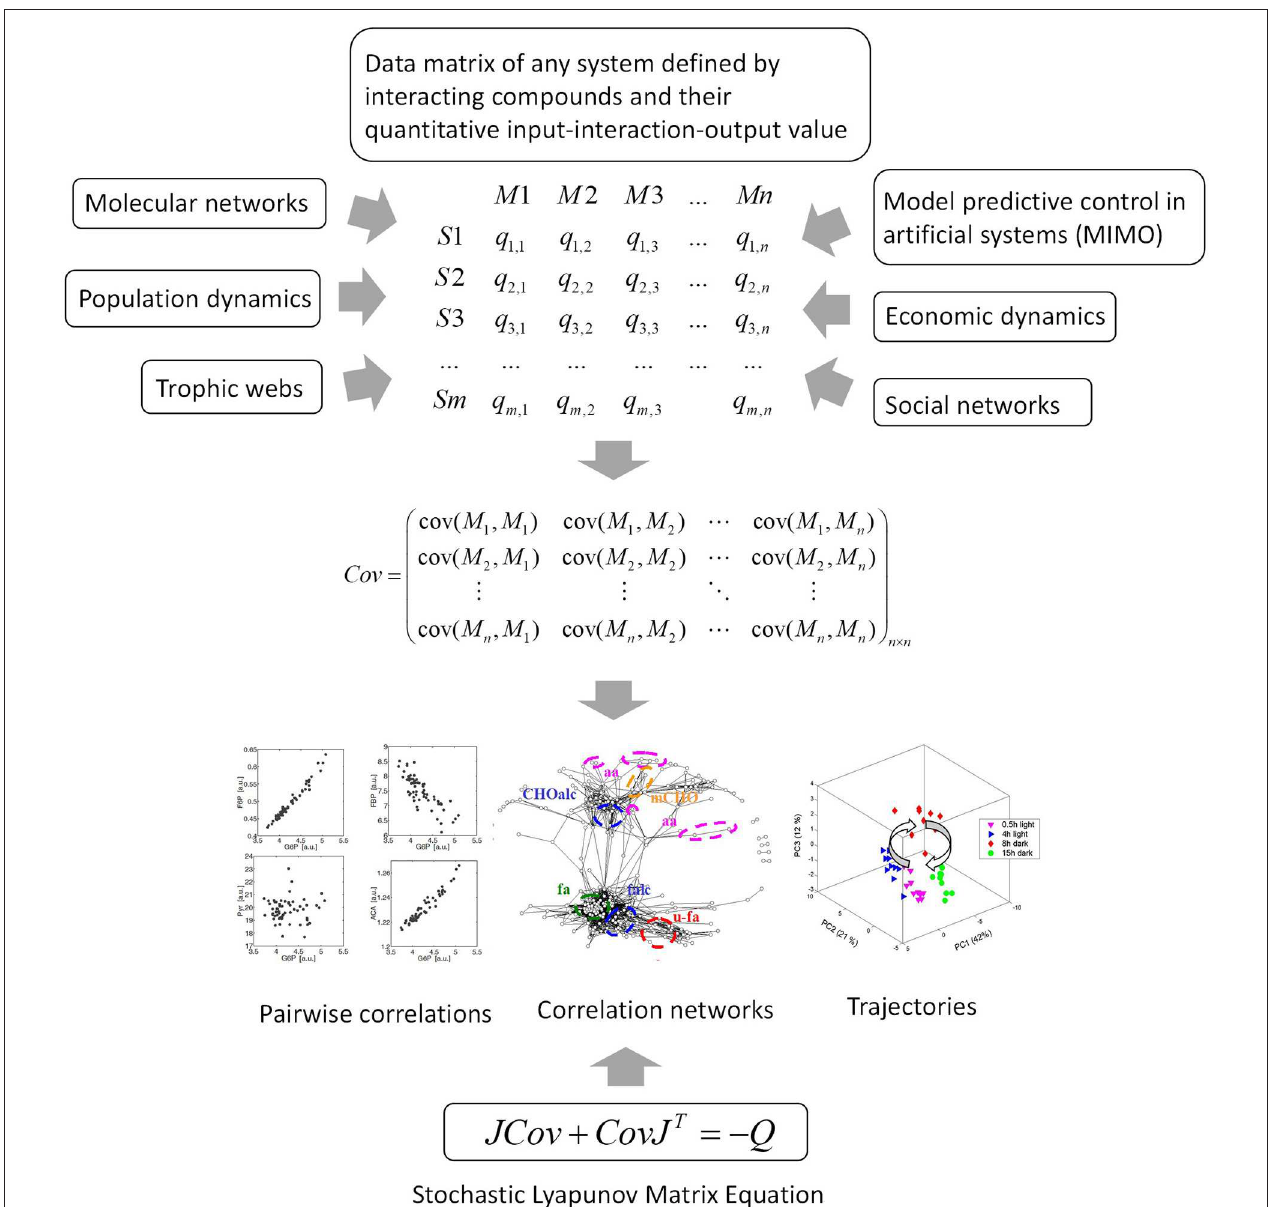
FIGURE 6 | The data matrix and the stochastic Lyapunov matrix equation are directly associated by multivariate properties of the system. This applies to any complex network or system and even to model predictive control of artificial intelligence systems. MIMO, multiple input multiple output.